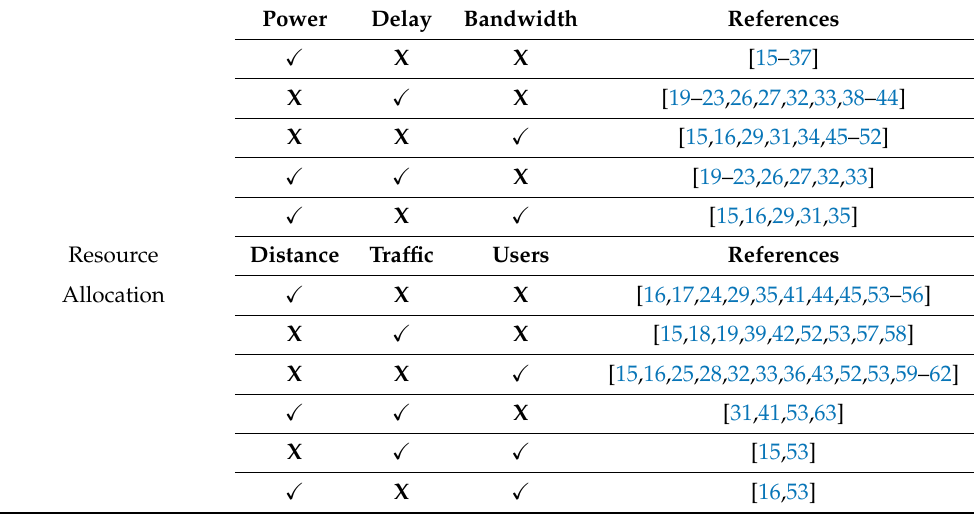
Table 1. Resource allocation classification of